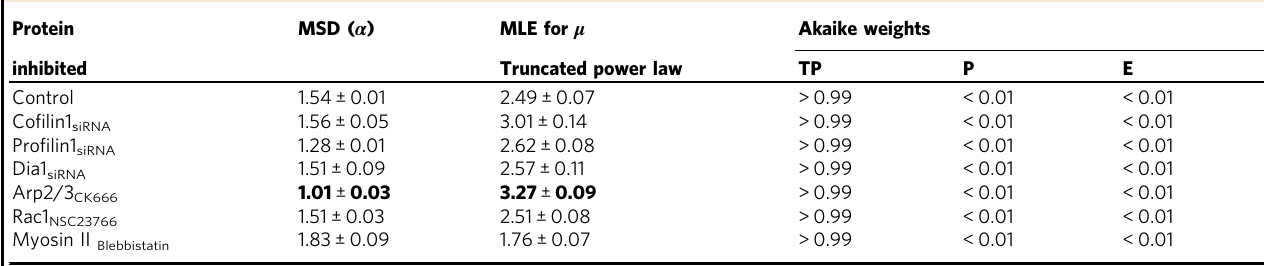
Table summarizes α exponent values and the maximum likelihood estimates, MLEs 70 , of the truncated power exponents μ for all treatments (±values give the 95% con fi dence intervals) described in Fig.5.Fortheknockdowns,thevaluesshowncorrespondto30nM siRNAconcentrations.Forthechemicalinhibitorsdatashowncorresponds to:40 μ M CK666(forArp2/3),100 μ MNSC23755(Rac1), 10 μ M Blebbistatin (Myosin II). The additional results for all drug and siRNA concentrations tested are shown in Supplementary Figures 10 – 14. Notice that Arp2/3 inhibition (highlighted in bold) reverts motions to diffusive characterized by α ~ 1 and truncated power law distribution with μ >3 . Lower cutoff values were a = 6 for Control, Co fi lin1, and Pro fi lin1 siRNAs, and a = 3 for other treatments. Note that in all cases truncated power law (TP) distribution is favored over power law (P) and exponential (E) distributions, and diffusive-vs-Lévy characteristic is determined by the magnitude of the μ exponent.Analysesbasedonthefollowingnumbersofcellsandtimepoints:Control( n = 69cells, m = 17,569timepoints);Co fi lin1 siRNA ( n = 25cells, m = 7,466timepoints);Pro fi lin1 siRNA ( n = 29cells, m = 7,250timepoints);Dia1 siRNA ( n = 7cells, m = 2,017timepoints);Arp2/3 CK666 ( n = 36cells, m = 9,008timepoints);Rac1 NSC ( n = 26cells, m = 7,407timepoints);MyosinII Blebbistatin ( n = 26cells, m = 5,413 time points). See Supplementary Movies 9 – 12 and Supplementary Movies 16 –